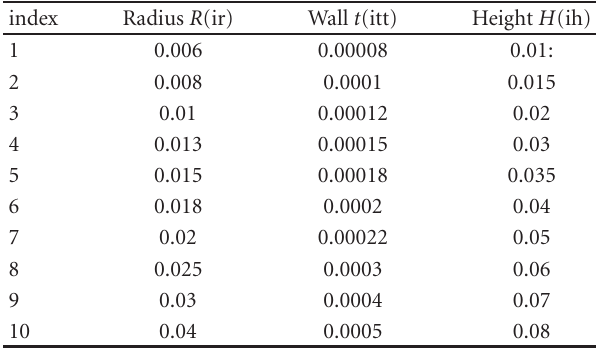
Table 2: Geometrical design variables.